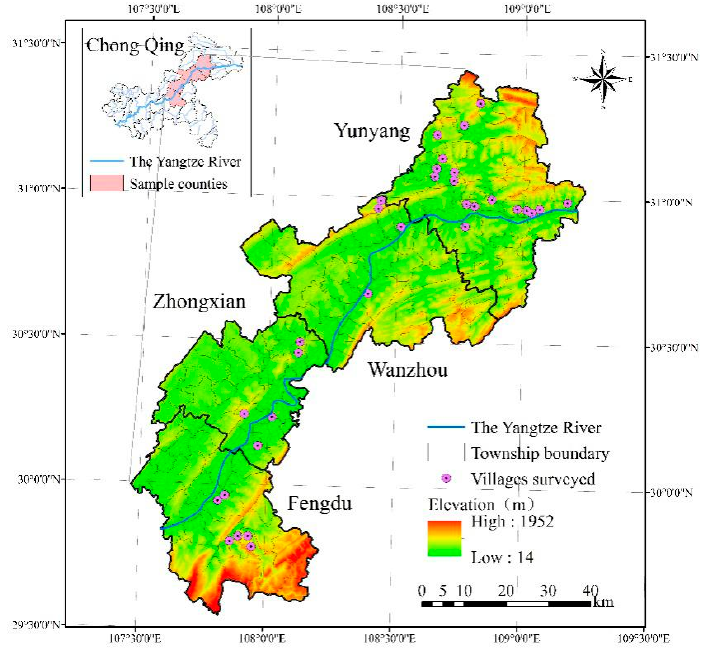
Figure 2. Locations of the sample villages .